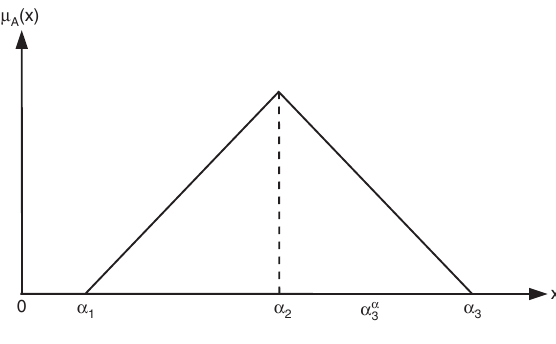
Figure 3 The neighborhood of numbers.